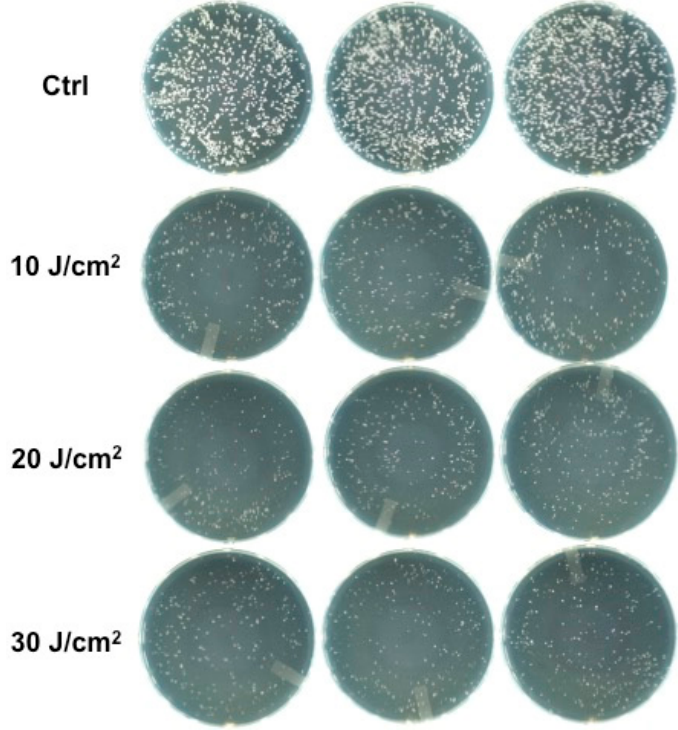
Figure 2. Colonies observed in agar plates after 20 μ L from every Eppendorf tube without erythrosine irradiated with the 532 nm green diode laser was taken, streaked on a plate, and incubated for one day.